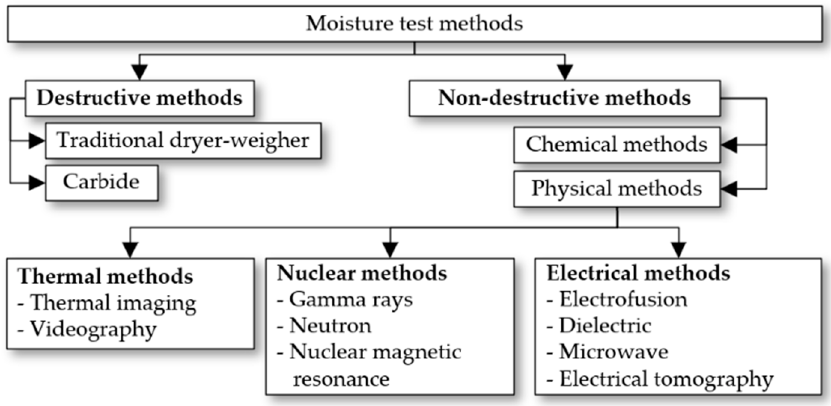
Figure 1. Division of methods for testing the humidity of materials and building partitions